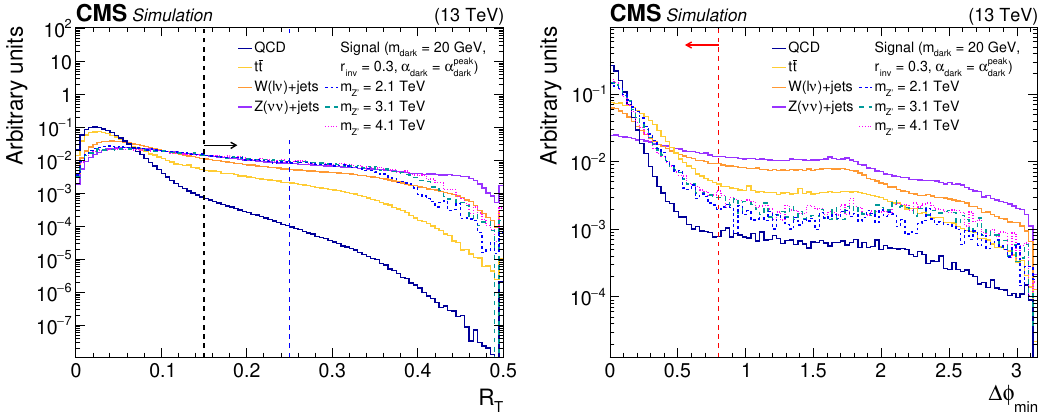
and ∆ φ for the T min